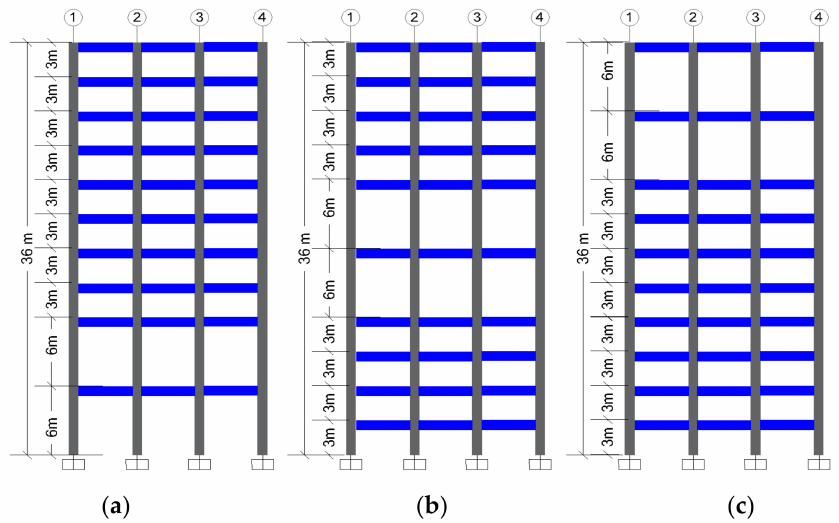
Figure 4. Building models with stiffness irregularity: ( a ) bottom stiffness (BS); ( b ) middle stiffness (MS); ( c ) top stiffness (TS).